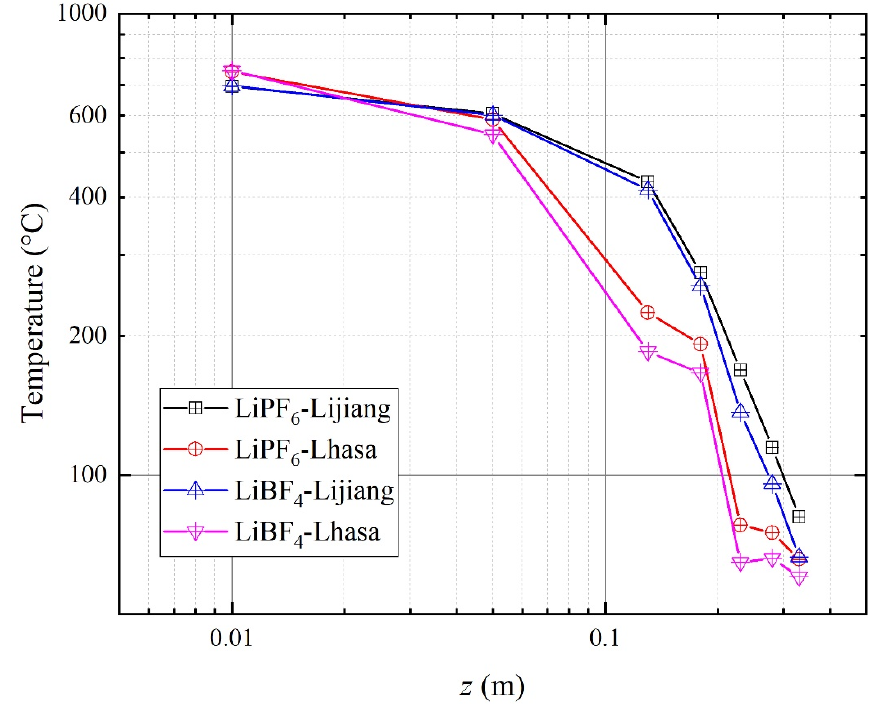
Figure 5. The average fire centerline temperatures at different heights of the two samples under different pressures during the stable combustion stage.